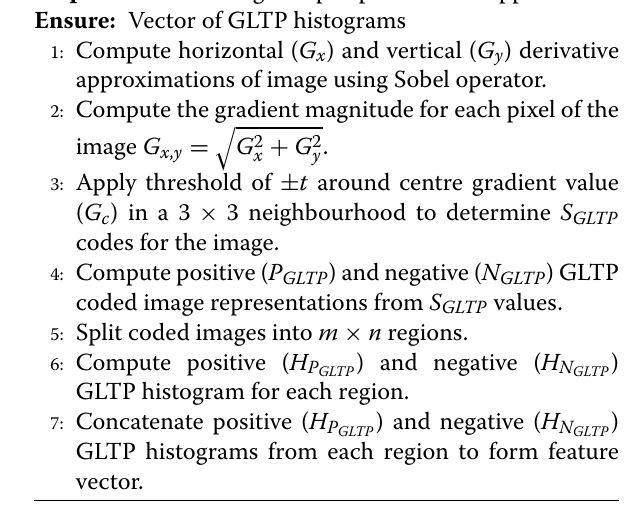
Algorithm 1 Gradient Local Ternary